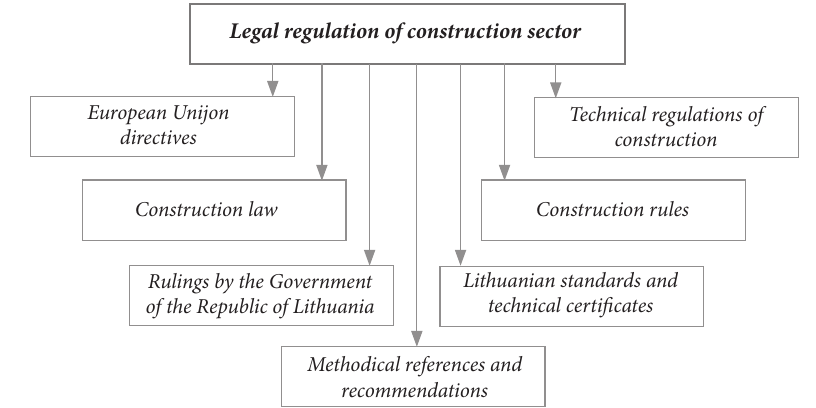
Fig. 5. Legal regulation of the construction